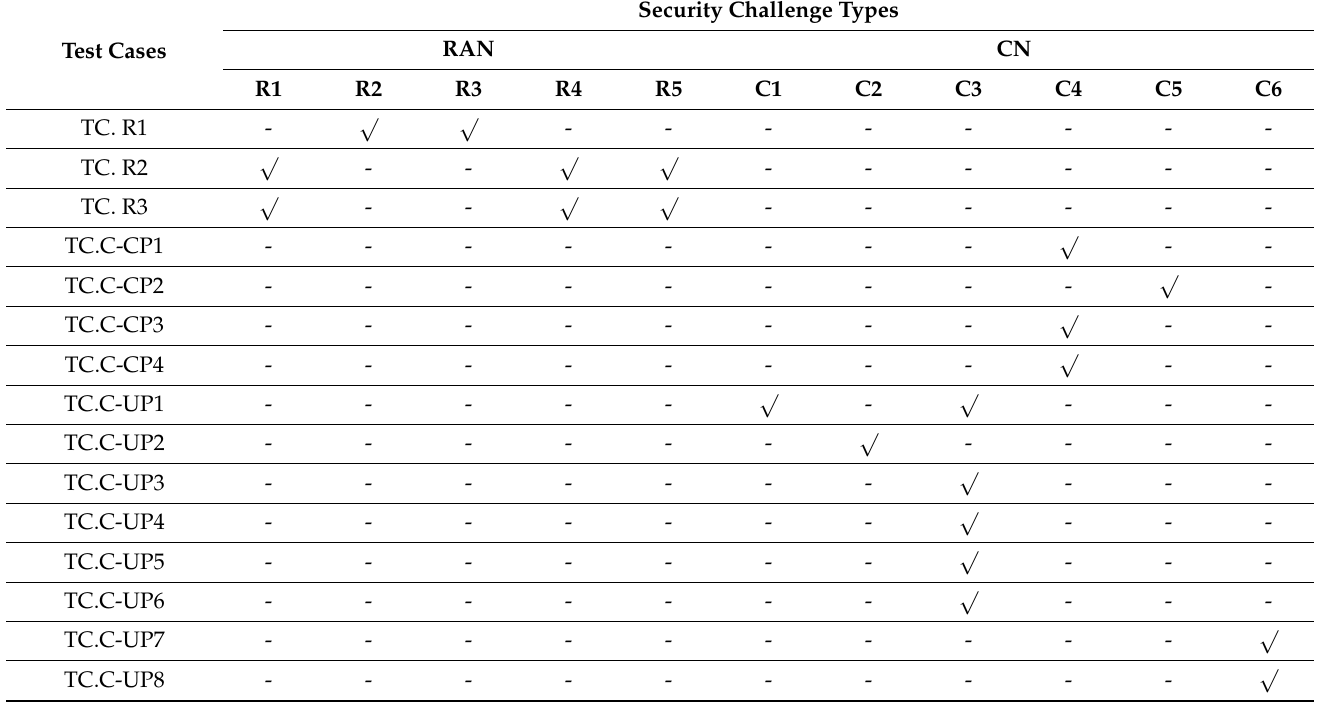
Table 6. Security challenges and test cases